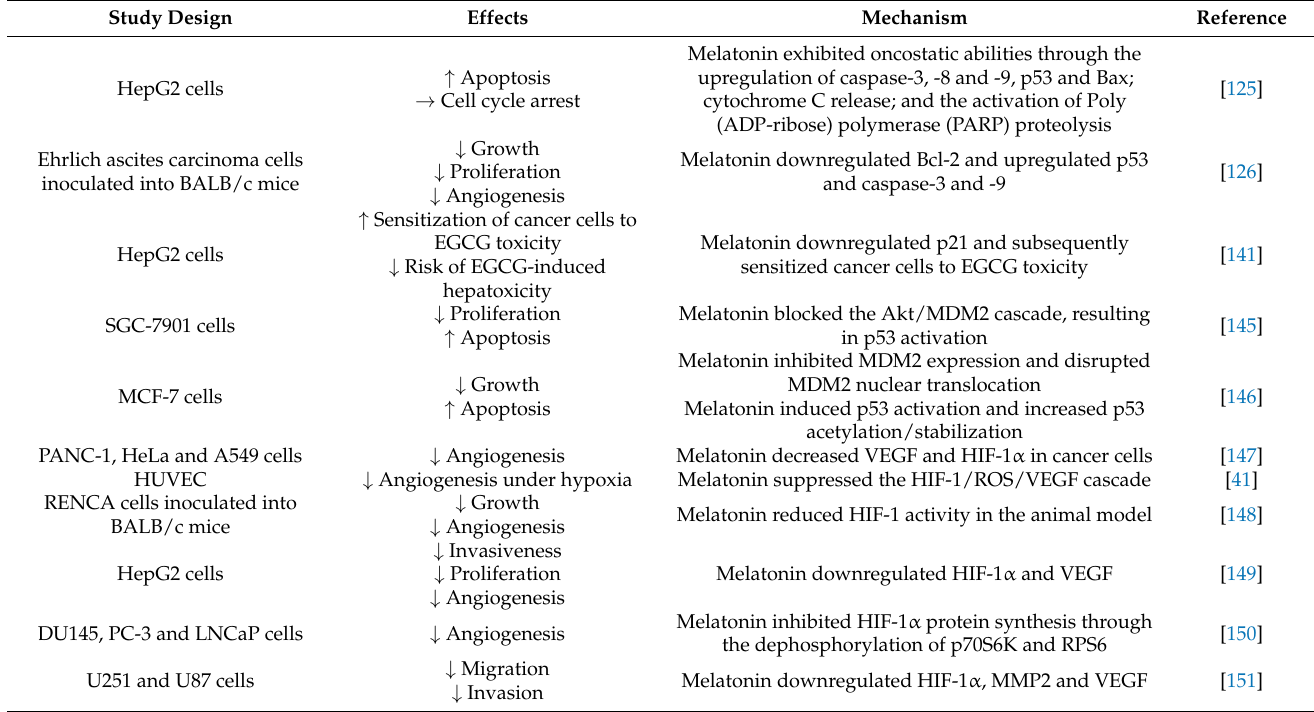
Table 2. Melatonin’s impact on critical regulators related to cancer